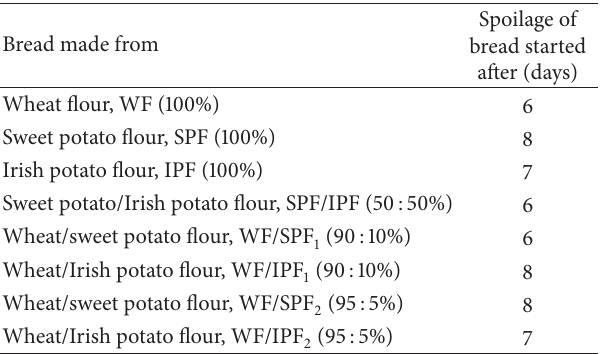
Table 5: Length of time bread produced remained whole. Bread made from